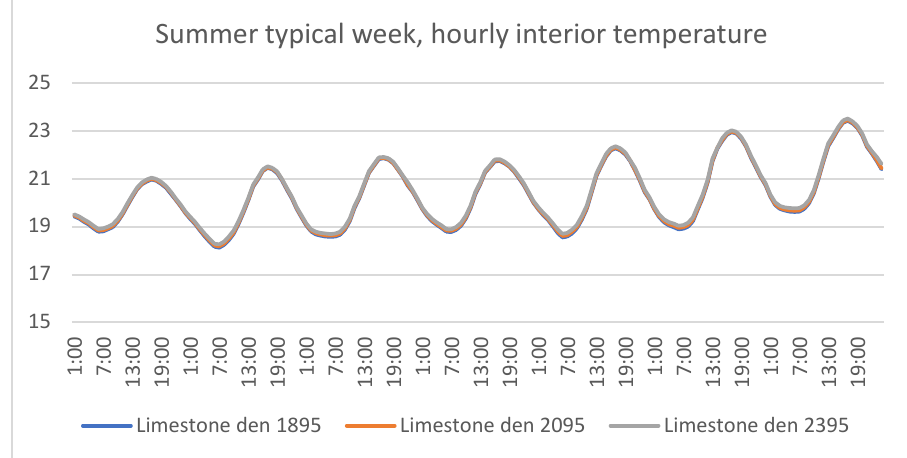
Figure 6. Typical summer week, hourly interior temperature.